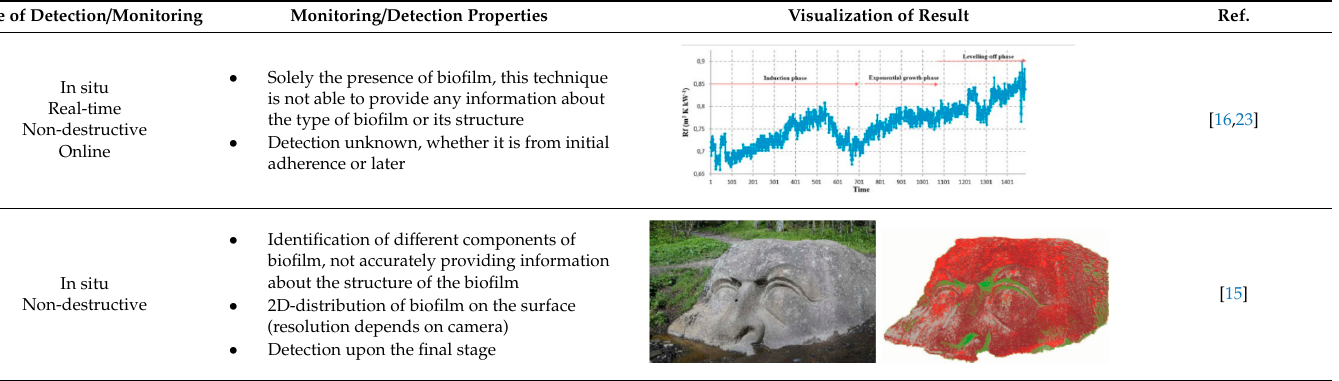
Table 2. Biofilm detection and / or measuring techniques and their properties and visualization type based on the literature. The di ff erent types of detection / monitoring are as follows: in situ, real-time, non-destructive, and online. If one of the references states that the specific technique can perform biofilm detection according to one of these four types of detection / monitoring, this is stated in column 2. Furthermore, two articles may claim di ff erent types of detection / monitoring, when this phenomenon occurs, a small description is given within brackets. The third column consists of the monitoring / detection properties of the di ff erent techniques. The goal of this column is to summarize the possible results obtained by applying a specific detection technique. Furthermore, the moment of detection is stated (i.e., beginning, middle, or end of biofilm formation phenomena). The fourth column contains a visualization of the result obtained by applying a specific technique. Types of possible results are a graph, picture, or